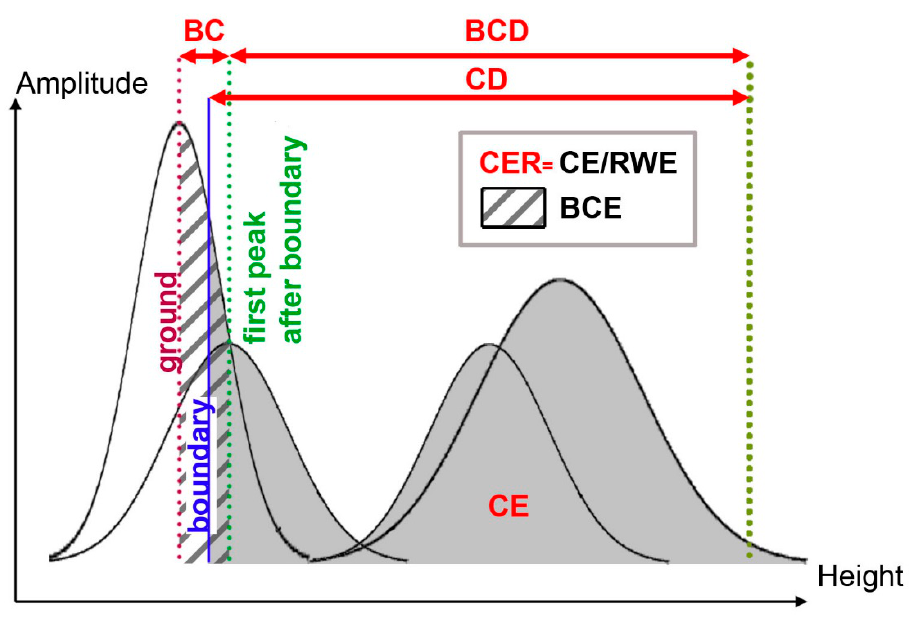
Figure 3. Representation of ALS FW metrics BC: bottom of canopy, BCD: bottom of canopy distance, BCE: bottom of canopy energy, CD: canopy distance, CE: canopy energy, and CER: canopy energy ratio, which depends on RWE: return waveform energy.